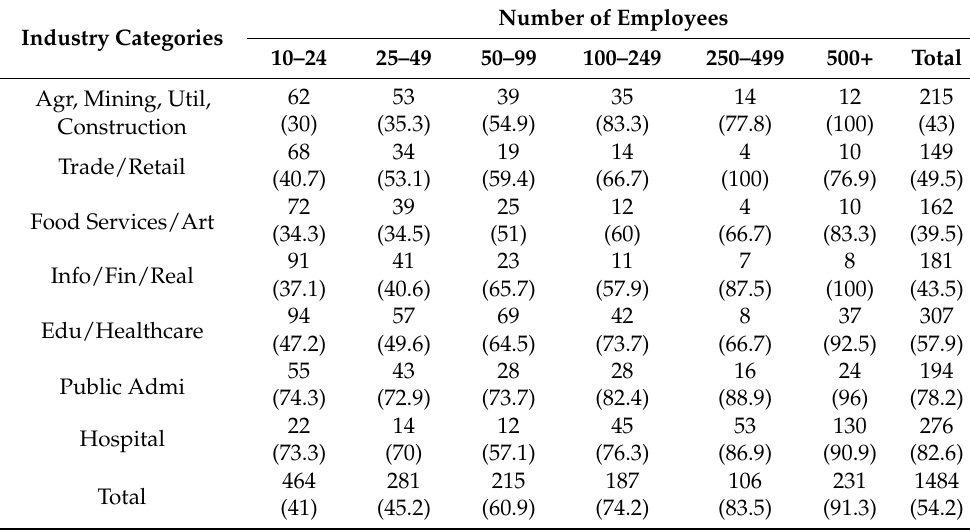
Table 2. Firms with WHPs in last 12 months